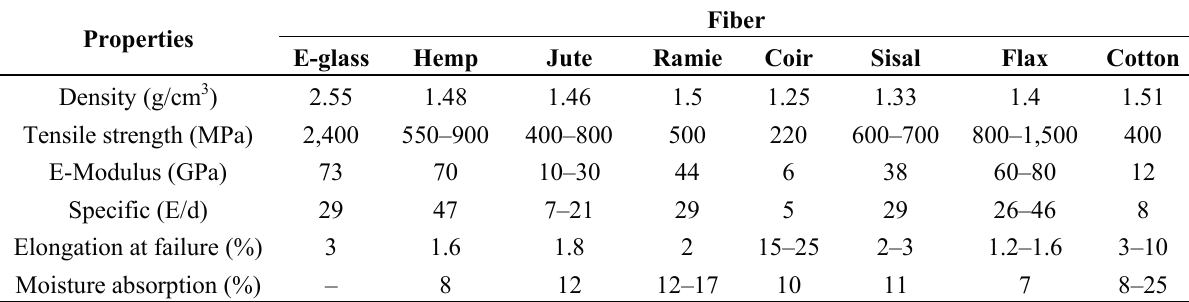
Table 5. Properties of natural fibers in relation to those of E-glass. Reprinted with permission from 010 Publishers, 2005